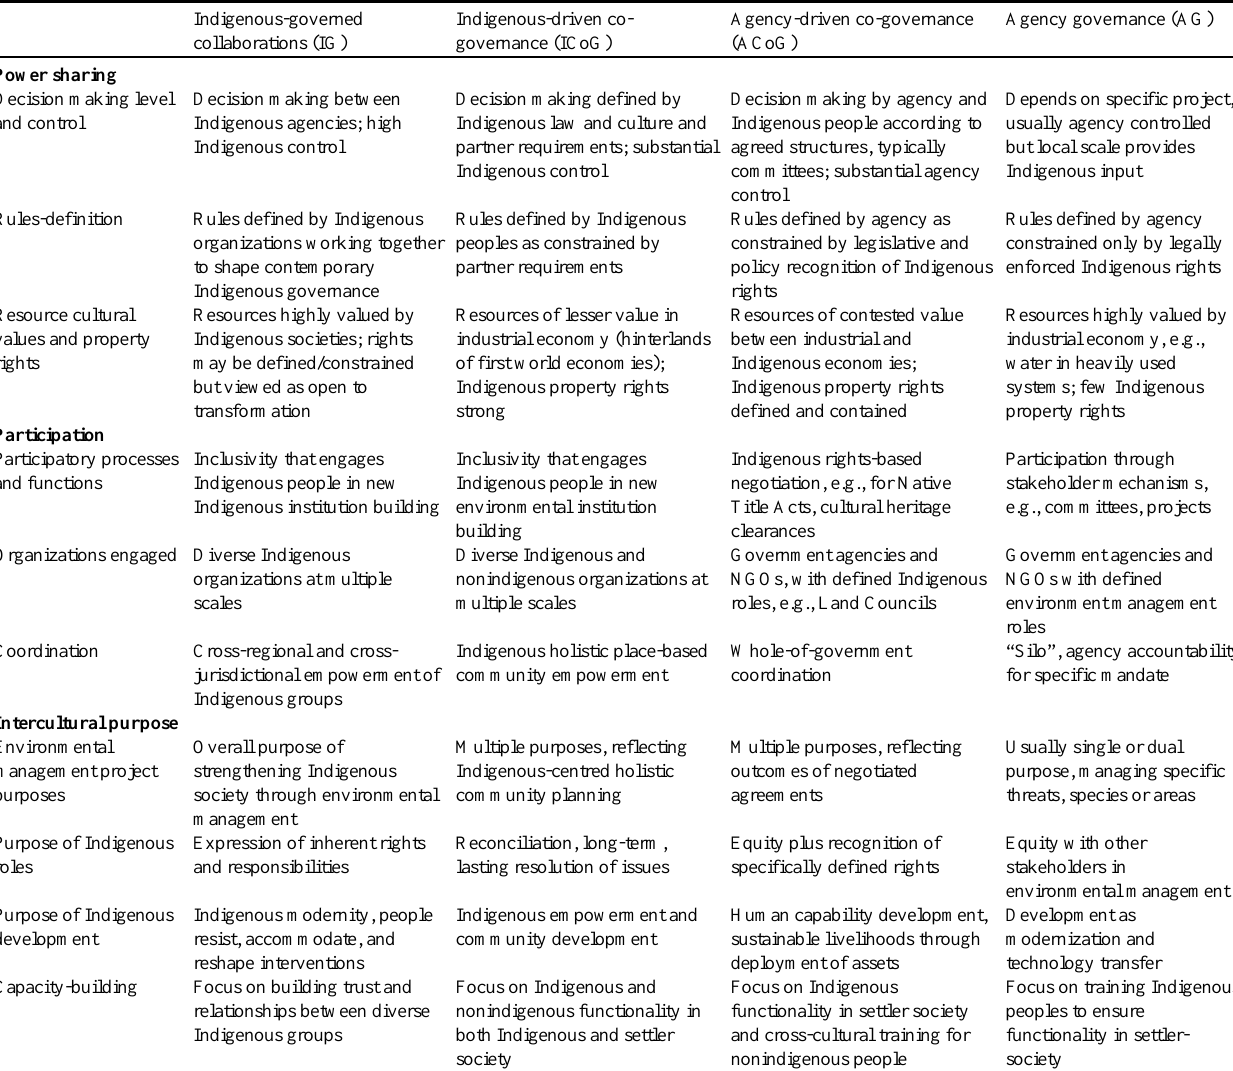
Agency governance